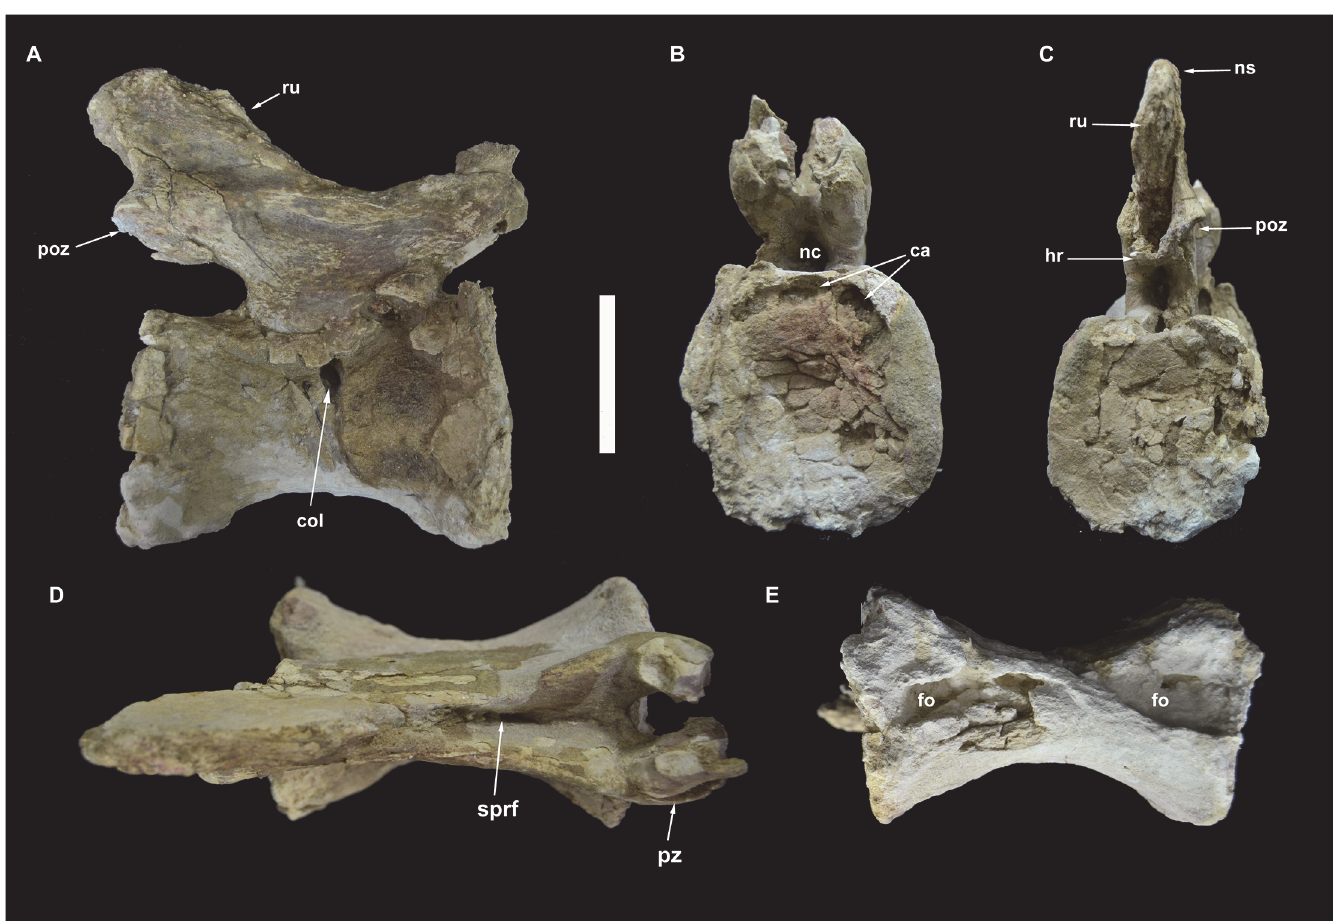
Fig 17. Caudal vertebra 16 of Tataouinea hannibalis . Vertebra in right lateral (A), proximal (B), distal (C), dorsal (D) and ventral (E) views. Scale bar: 10 cm. Abbreviations: ca, camerae; col, collapsed area; fo, fossae; hr, hyposphenal ridge; nc, neural canal; ns, neural spine; poz, postzygapophysis; pz, prezygapophysis; ru,